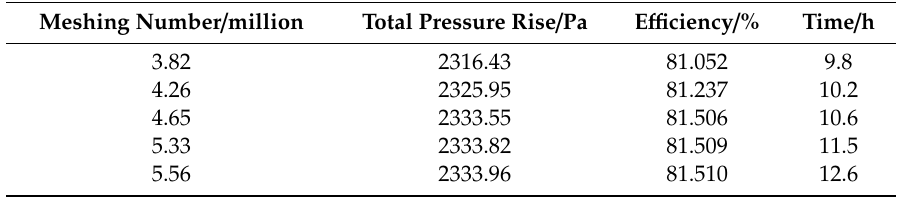
Table 3. Validation of mesh independence.